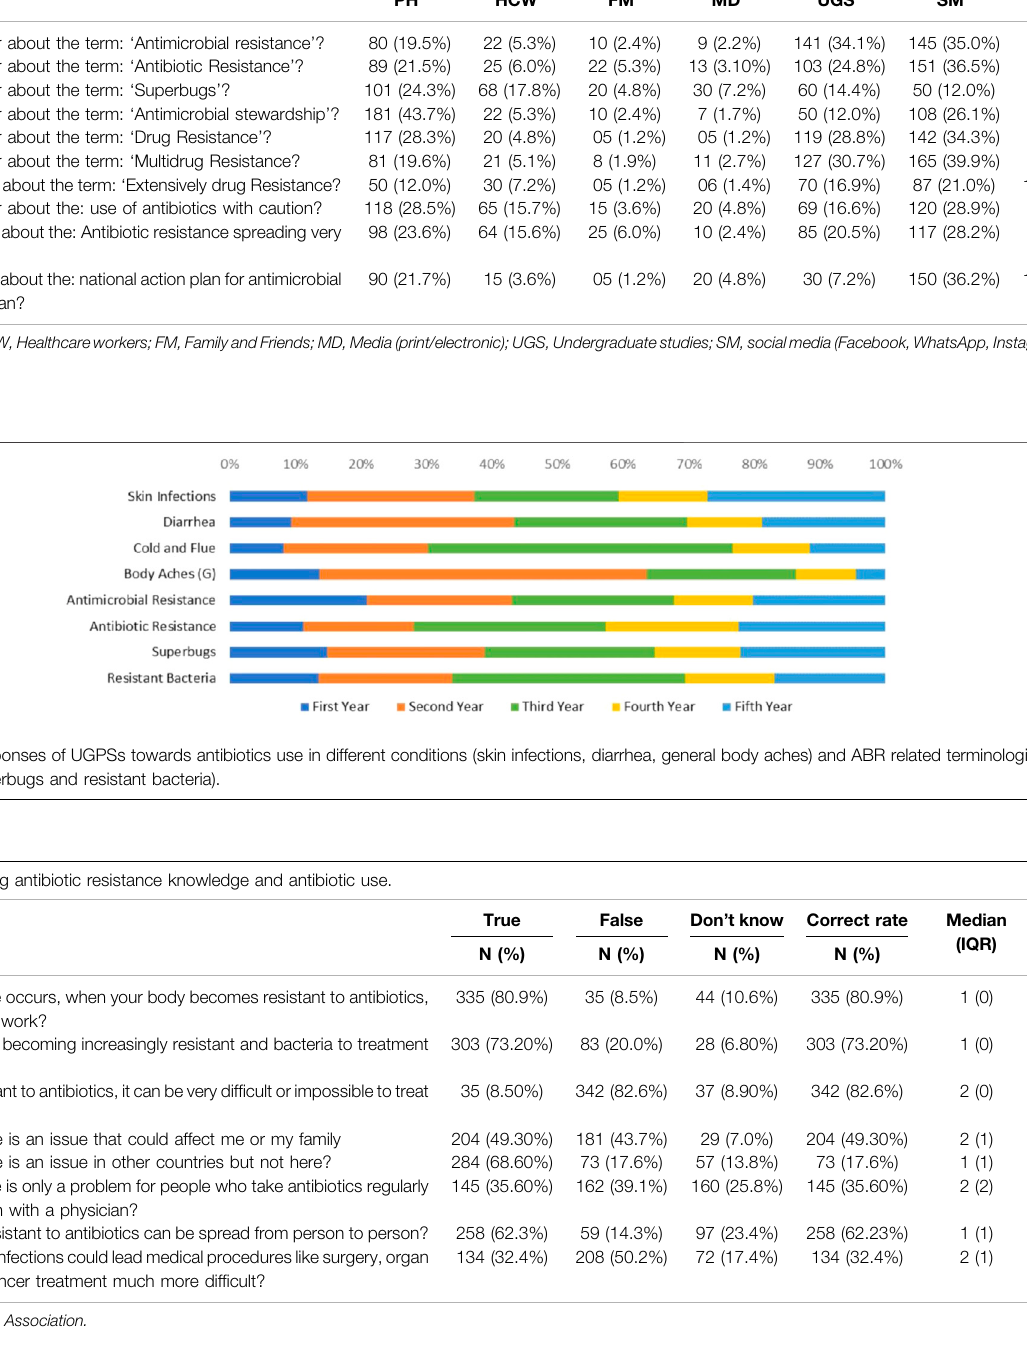
TABLE 3 | Exploring knowledge related to terminologies awareness and their sources. Questions